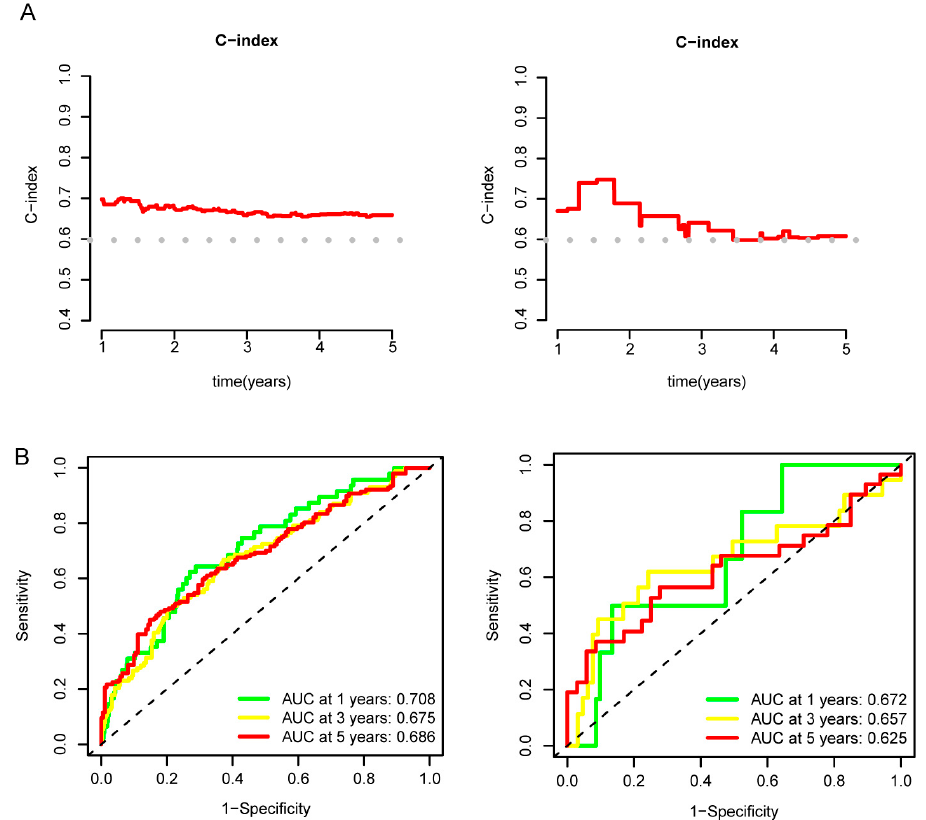
Figure 8. Construction of the SPAG9 -based ccRCC prognostic model. ( A ) A nomogram to predict the prognoses of ccRCC patients, containing age, gender, and risk score. Total Points = (0.899 × age − 22.468) + ( − 1.508 × gender + 1.508) + (38.462 × RiskScore + 130.769). ( B ) Calibration plots of the nomogram for predicting OS at 1-, 3-, and 5-year survival rates. T, actual survival proportion, is plotted on the y-axis with 95% confidence. Nomogram-predicted survival probability is plotted on the x-axis. The gray line is an ideal curve, with a slope of 1.